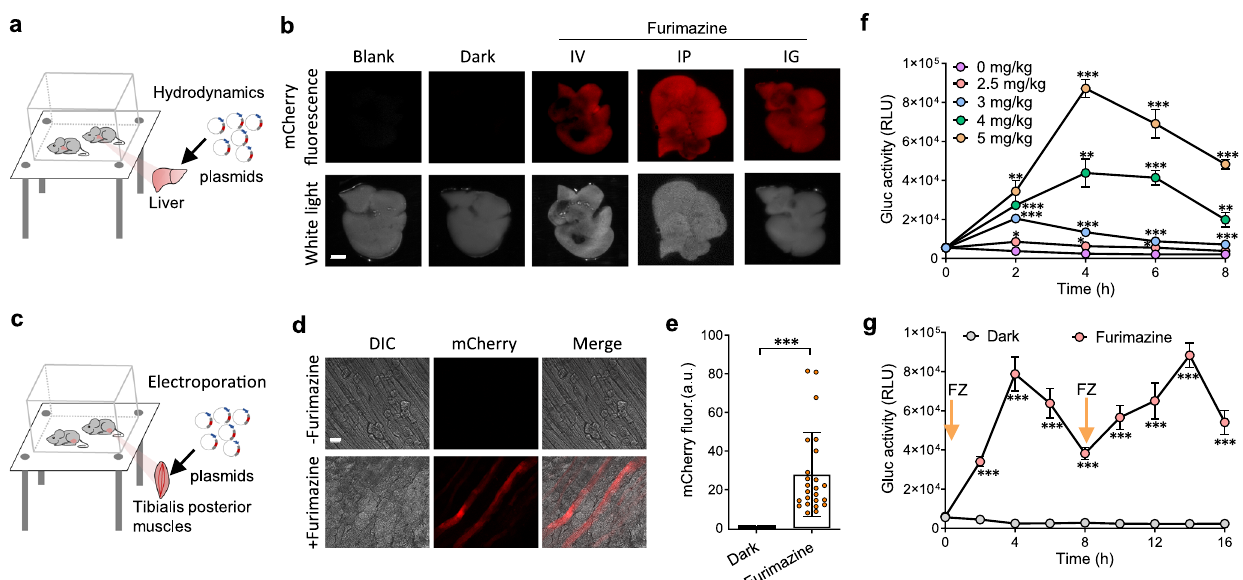
Fig. 3 Pulsatile activation of transgene expression mediated by luminGAVPO in mice. a Schematic representation of luminGAVPO-activated transgene expression in mouse livers. The KM mice were transiently hydrodynamically injected (tail vein) with an iteration of the luminGAVPO system comprising the transactivator and reporter plasmids. b The transfected mice in ( a ) were kept in the dark and treated with 5 mg/kg furimazine via tail intravenous (IV), intraperitoneal (IP) or intragastric (IG) injection. The mice were sacri fi ced, and the livers were dissected for mCherry fl uorescence imaging. Scale bar, 0.5 cm. c Schematic representation of luminGAVPO-activated transgene expression in mouse tibialis posterior muscles. The luminGAVPO and reporter plasmids were transfected into the tibialis posterior muscles via electroporation. d The transfected mice in ( c ) were kept in the dark and treated with or without 5 mg/kg furimazine via IV administration. Twenty-four hours after induction, the mice were sacri fi ced, and the skeletal muscles were dissected, sectioned and imaged. Scale bar, 100 μ m. e Quanti fi cation of mCherry fl uorescence in muscle cells. Statistical comparison was performed by a two-tailed t test. *** P < 0.001 versus control. Data represent the mean ± s.d. ( n = 24 cells from 3 mice). f Time course of Gluc expression kinetics induced by different concentrations of furimazine. g Reversible activation of Gluc expression induced by furimazine. The transfected mice were kept in the dark and treated with 5 mg/kg furimazine via IV administration at 6 h and 14 h after plasmid transfection, respectively. Gluc activity in the bloodstream was measured at the indicated time points after the fi rst induction. All statistical comparisons were performed by a two-tailed t test. * P < 0.05, ** P < 0.01, *** P < 0.001 versus control. Data in ( b , d , f and g ) represent the mean ± s.d. from three ( b , d , f ) or fi ve ( g ) mice. For ( b and d ), at least two independent experiments were carried out with similar results. Source data are provided in the Source Data fi